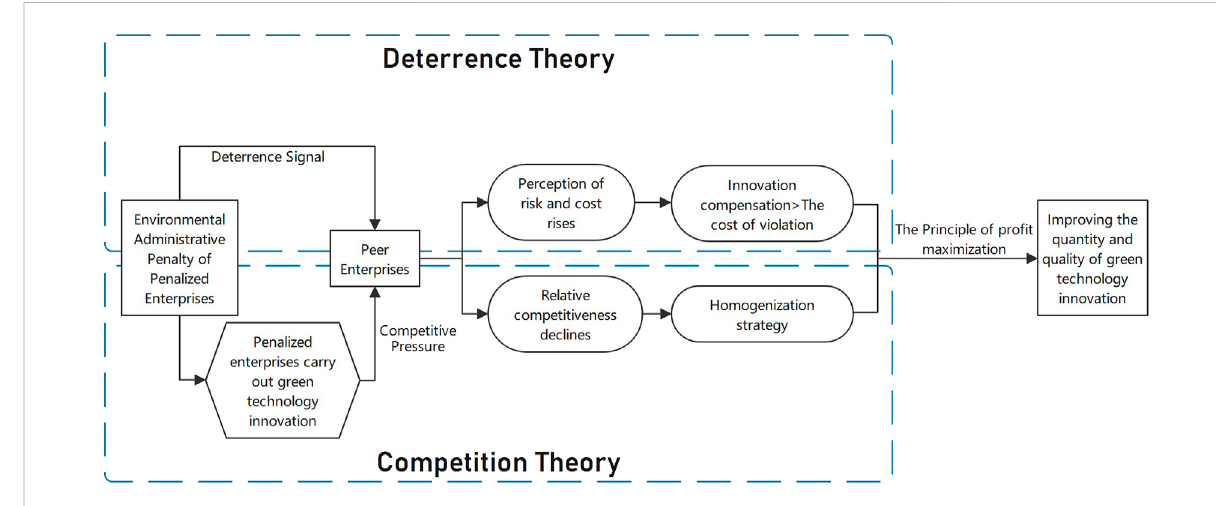
FIGURE 1 Theoretical analysis framework